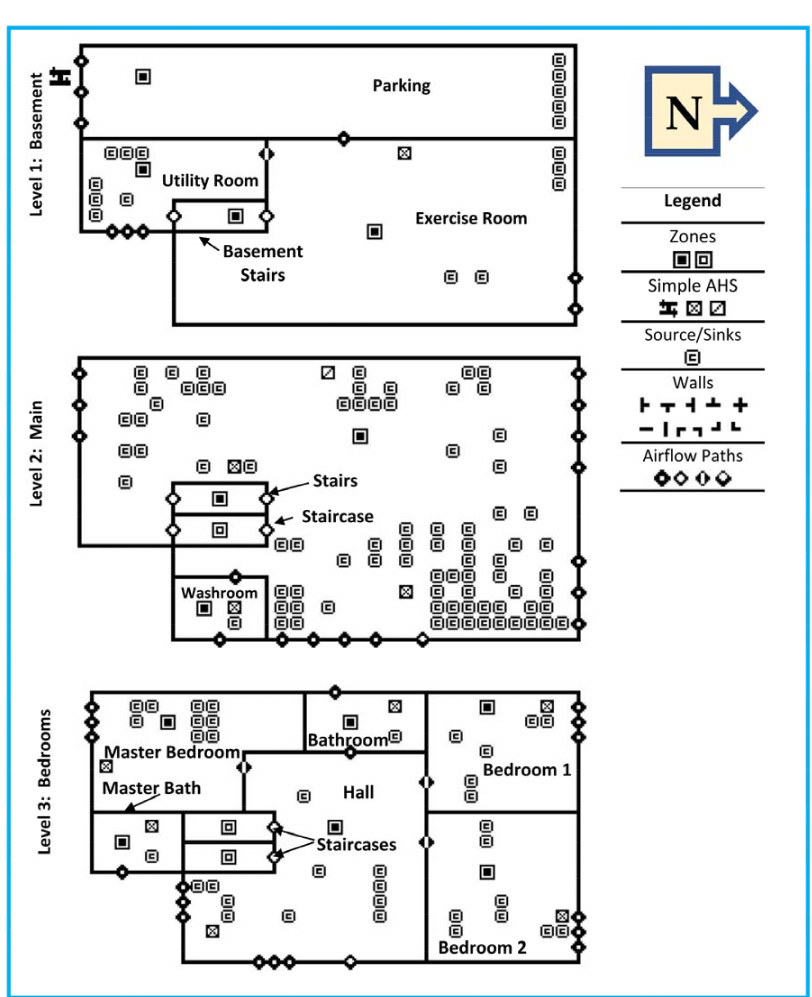
Figure 3. Floor plans of basement level (utility room, exercise room, parking, and staircase), main level (living room, kitchen, washroom, and staircases), and bedrooms level (three bedrooms, two bathrooms, hall, and staircases), with locations of zones, AHS (air-handling system), source and sinks of contaminants, walls, and airflow paths for three-story house created by